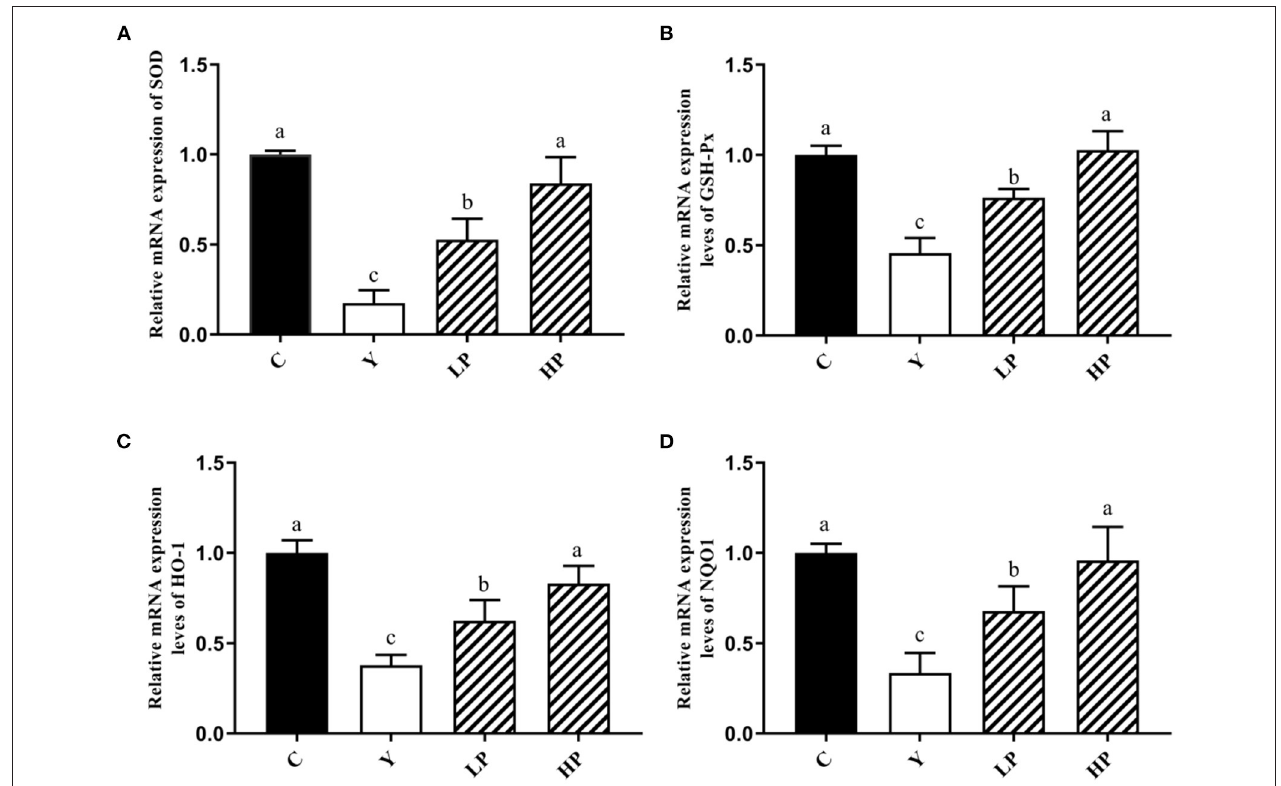
FIGURE 6 | Effects of OP on the relative mRNA expression levels of intestinal antioxidant factors SOD (A) , GSH-Px (B) , HO-1 (C) , and NQO1 (D) in oxidative injured mice. Different letters in the figure represent significant differences ( P < 0.05). C: the normal group; Y: the Cy-induced group; LP: Cy + 200 mg/kg OP; HP: Cy + 400 mg/kg